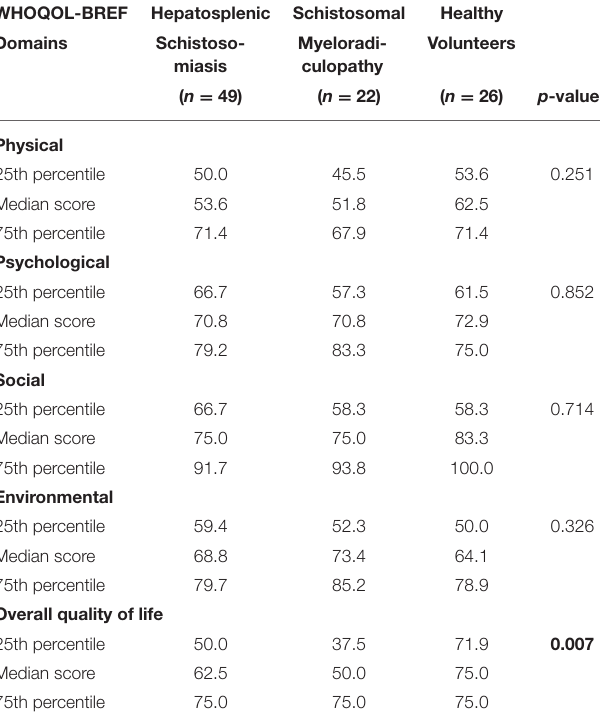
TABLE 2 | Analysis of perceived quality of life in schistosomiasis patients and non-infected volunteers based on the short form of the World Health Organization Quality of Life questionnaire (WHOQOL-BREF). WHOQOL-BREF Hepatosplenic Schistosomal